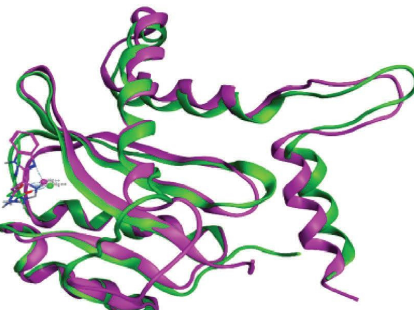
Figure 8: Close-up view of the binding interactions of compound (j) with HIV-1 integrase CCD dimer. Colored purple is before MD simulation and colored green is after MD simulation.